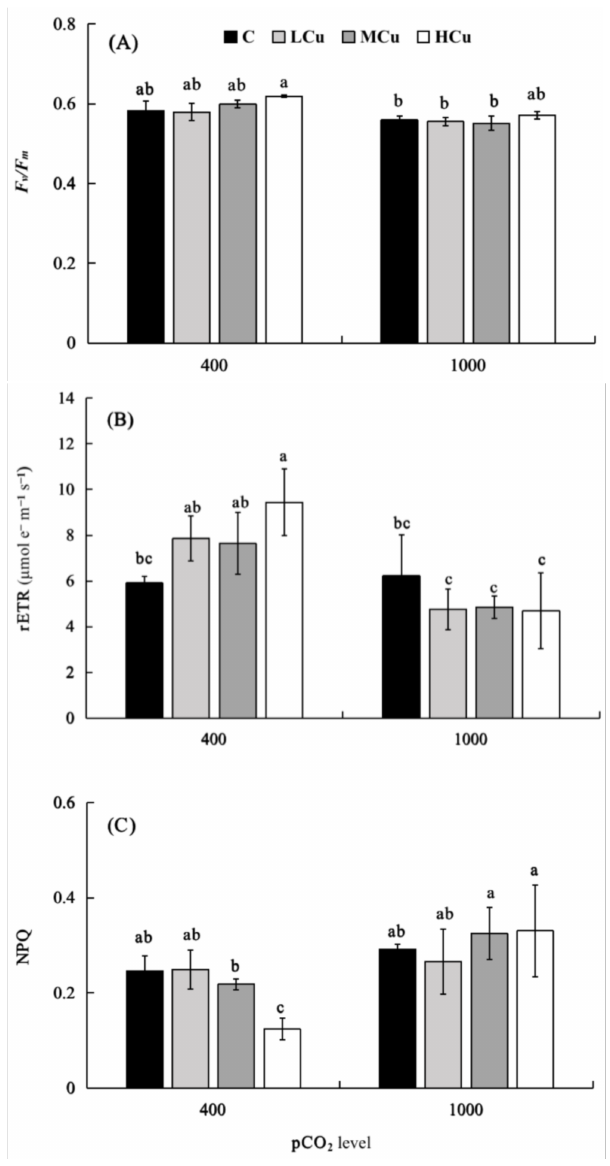
Figure 2. Photosynthetic parameters (( A ), F v /F m ; ( B ), rETR; ( C ), NPQ) of S. japonica grown at different pCO 2 levels and copper concentrations. C (control, natural seawater); LCu (low copper concentration, 0.2 µ M); MCu (medium copper concentration, 0.5 µ M); HCu (high copper concentration, 0.2 µ M). All results are shown as mean value ± SD ( n = 3). Different letters indicate statistical differences ( p < 0.05) among experimental